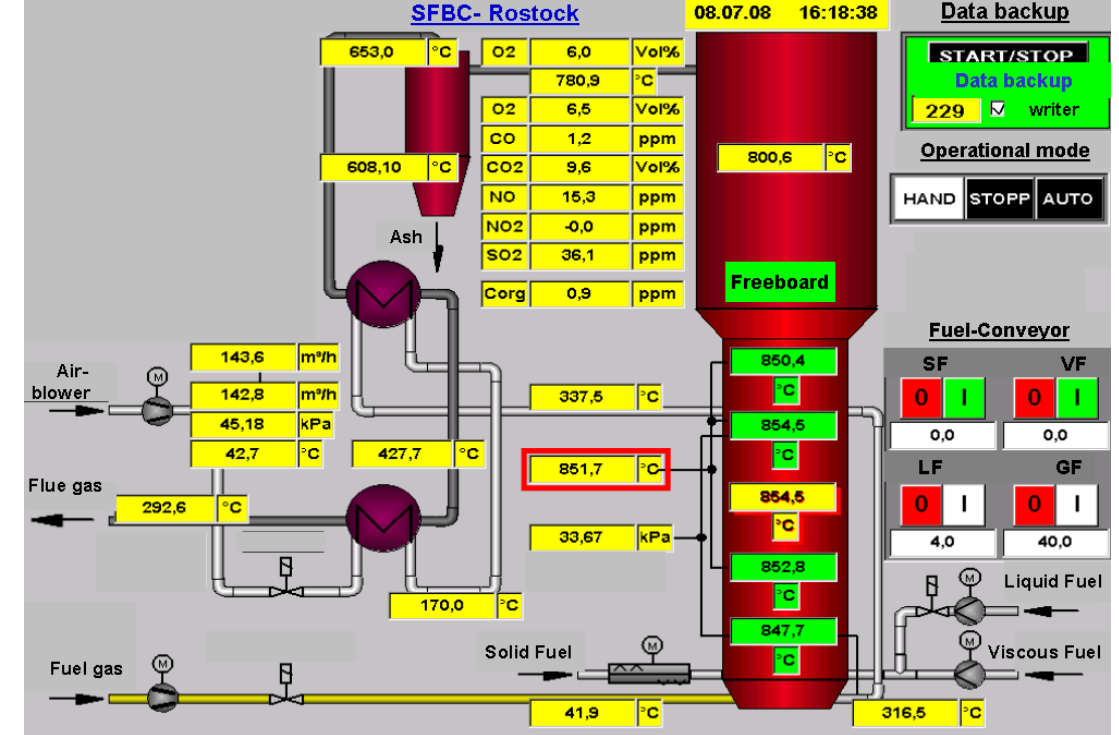
Figure 5. The technological flow sheet of SFBC at the CET, Rostock University, Germany